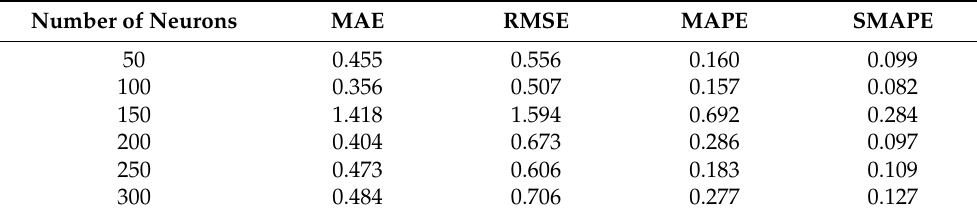
Table 2. The effect of the number of LSTM neurons on the prediction results. Number of